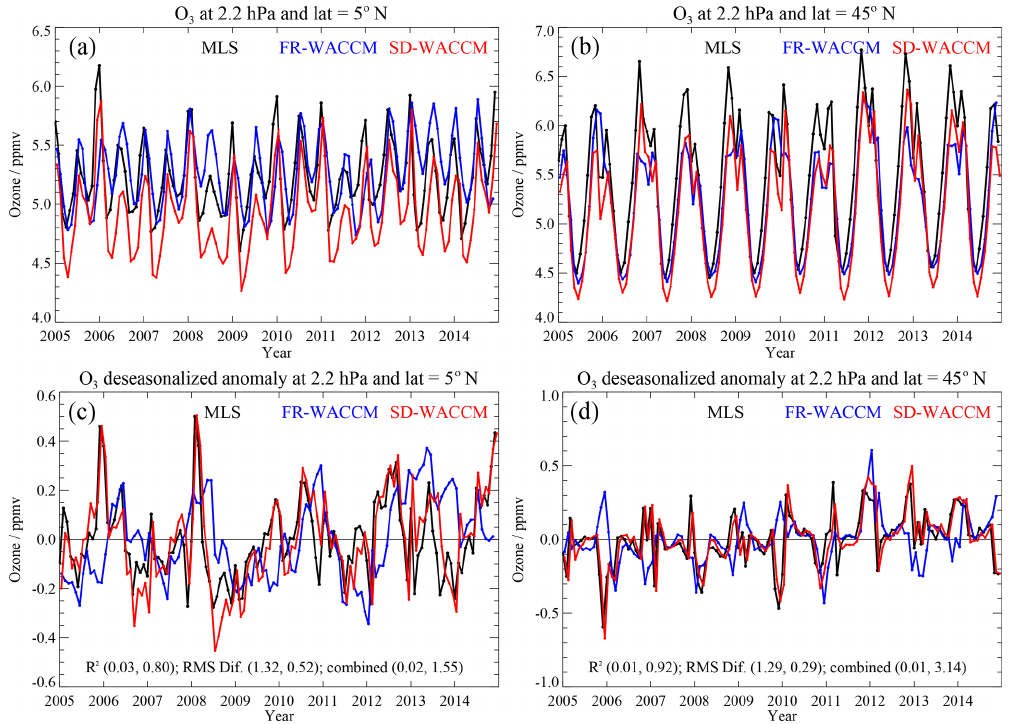
Figure 11. Time series of monthly zonal mean O 3 mixing ratios at 2.2hPa (a, b) and deseasonalized anomalies (c, d) , with the 0–10 ◦ N and 40–50 ◦ N latitude bins on the left and right, respectively. The two model time series (FR-WACCM in blue and SD-WACCM in red) are compared to the MLS series (in black) for 2005–2014. Diagnostic values (see text for a description) are shown in parentheses in the bottom two panels (c, d) , with the first number referring to FR-WACCM and the second number to